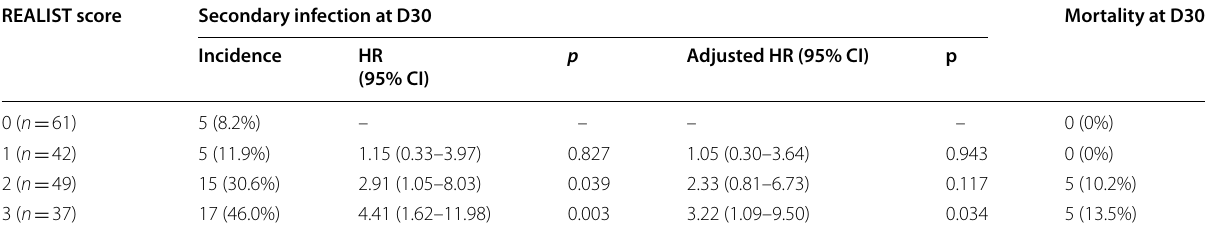
17 As measured in the cohort of interest ( n 189 ICU patients at days 5–7) = Hazard Ratios and P values were computed using univariate and adjusted Cox proportional hazards models from a priori identified clinical risk factors for secondary infection (SOFA score and mechanical ventilation at timepoint of interest) Values are presented with 95% CI